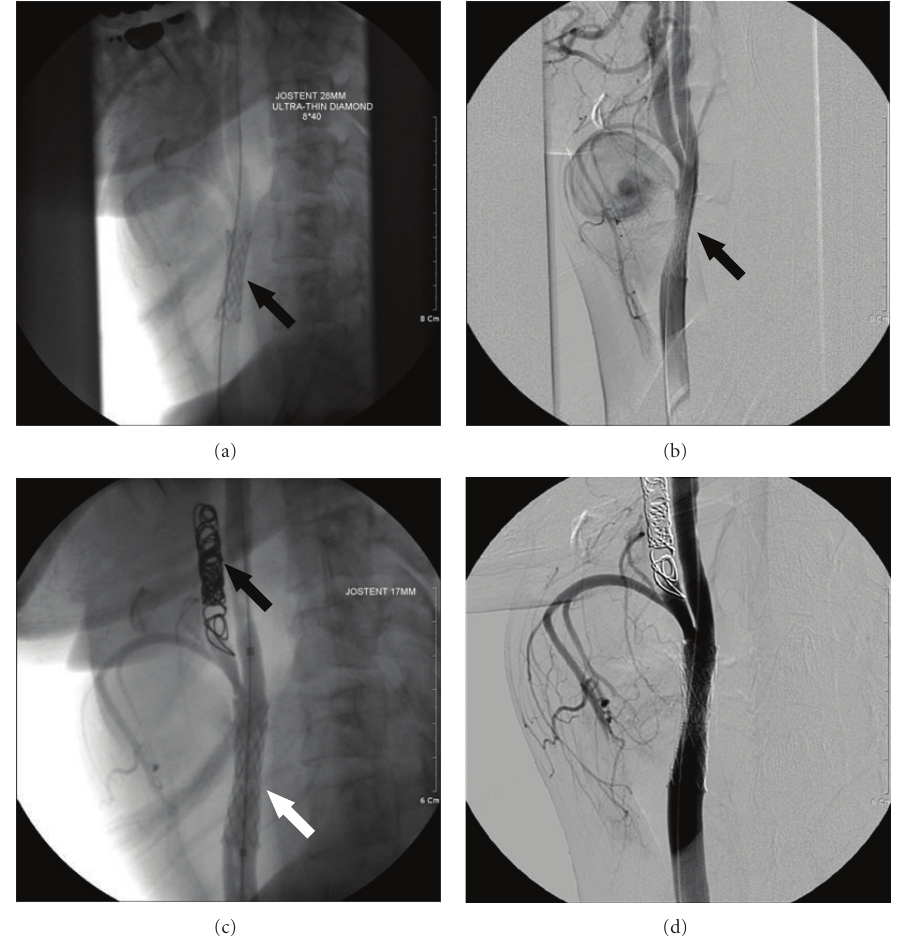
Figure 2: Intraoperative fluoroscopic image: (a) the Jostent was deployed at the right common carotid artery (black arrow). (b) Some extravasation of contrast material was noted at the pseudoaneurysm sac after stent deployment (black arrow). (c) The right external carotid artery was trapped by fibered coil (black arrow), and another Jostent (white arrow) was deployed in the right common carotid artery. (d) No contrast material was observed within the pseudoaneurysm after stent graft placement.